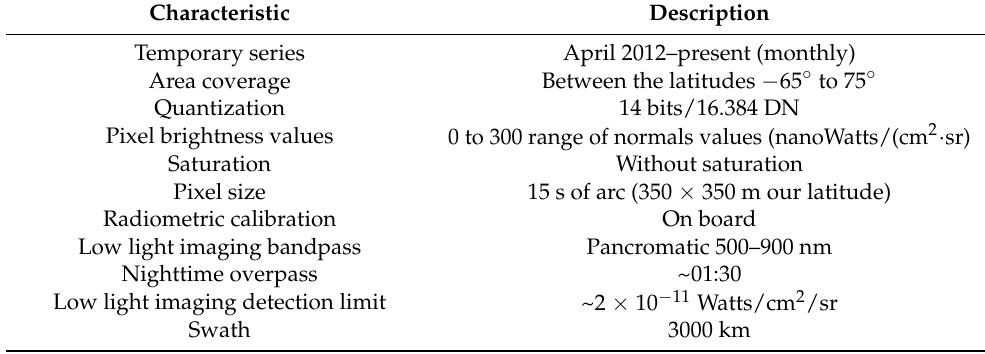
Table 1. Main characteristics of the data, VIIRS-DNB (Visible Infrared Imaging Radiometer Suite Day/Night